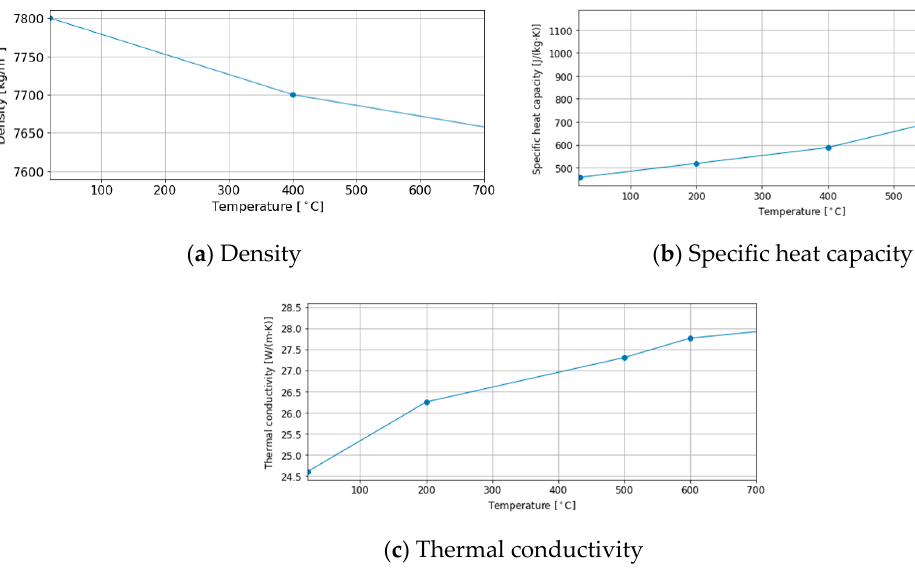
Figure 3. Temperature-dependent thermophysical properties of H13 tool steel.